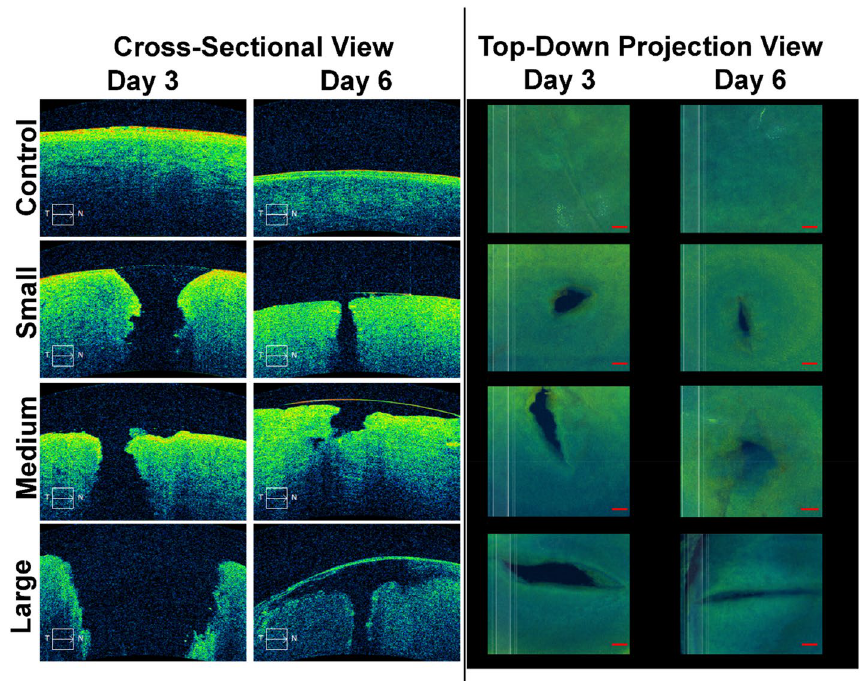
Figure 6. OCT analysis of OG injuries. Representative (left columns) cross-sectional and (right columns) top- down images of the cornea for control, uninjured (row 1), small (1.2 mm D, row 2), Medium (2.4 mm D, row 3), and Large (4.5 mm D, row 4) OG injuries. Images were taken immediately after OG injury (D3, column 1) and 72 h post injury (D6, column 2). Scale denoted by 0.3 × 0.3 mm square in corner of images (Left column) or 0.3 mm scale bar (right column).